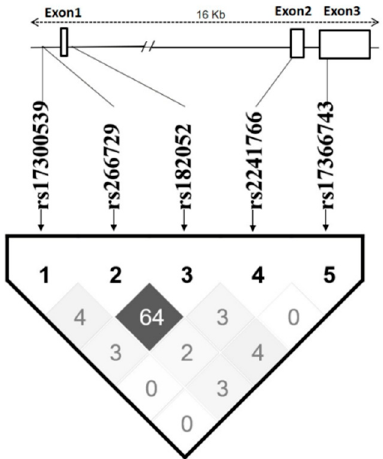
Figure 2. Linkage disequilibrium of the tested SNPs of the ADIPOQ gene. The values and colors of the cells correspond to the disequilibrium levels estimated according to the r2, % coe ffi